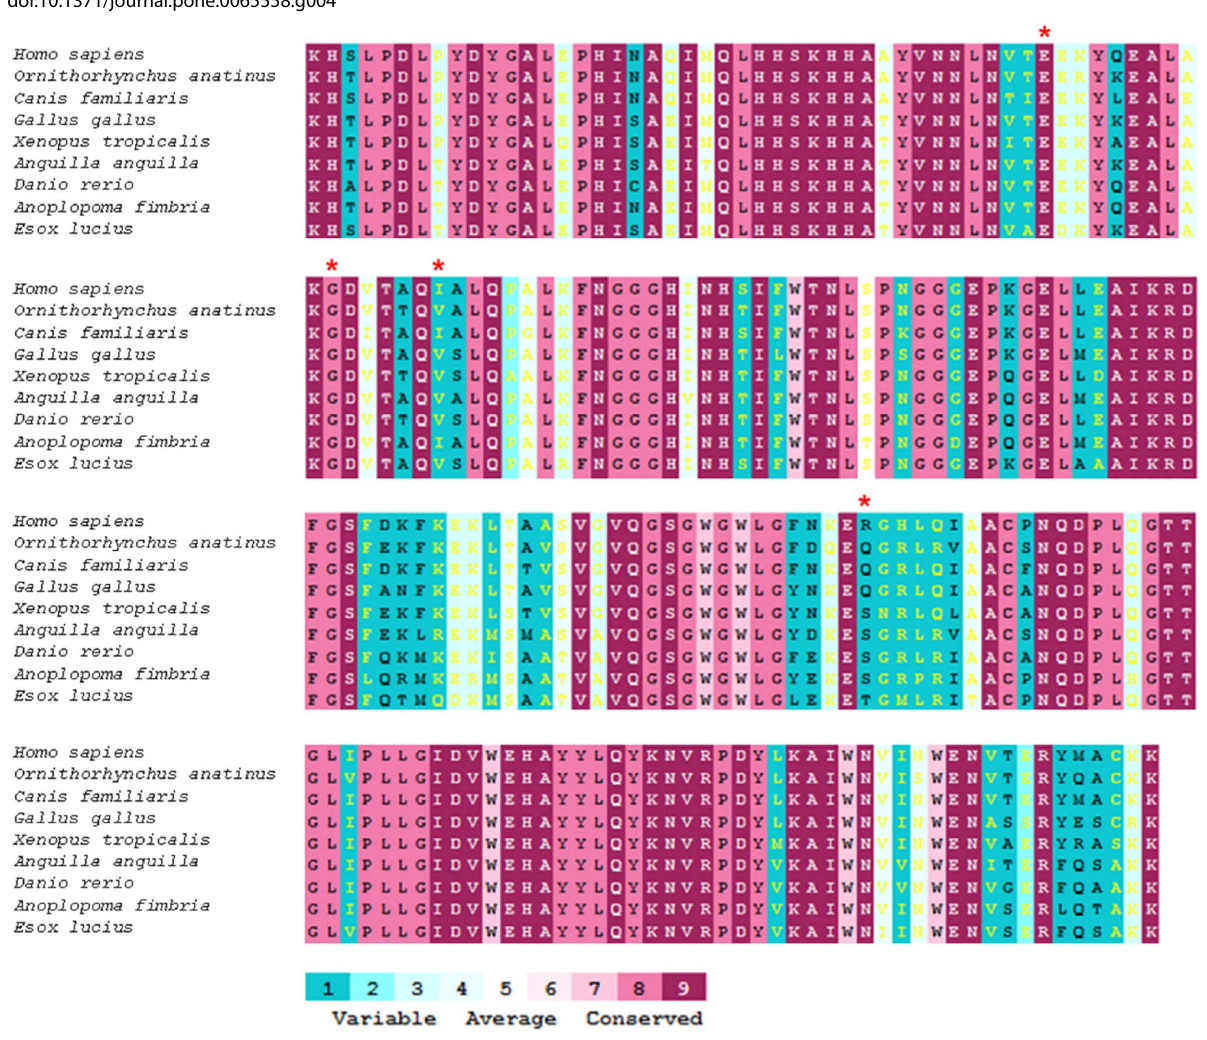
Figure 5. Multiple protein sequence alignment using ConSurf shows evolutionary conservation of amino acid residues. The colour- coding bar shows the colouring scheme: conserved amino acids are coloured bordeaux, residues of average conservation are white, and variable amino acids are turquoise. SNP positions are marked by an asterisk. doi:10.1371/journal.pone.0065558.g005 PLOS ONE |